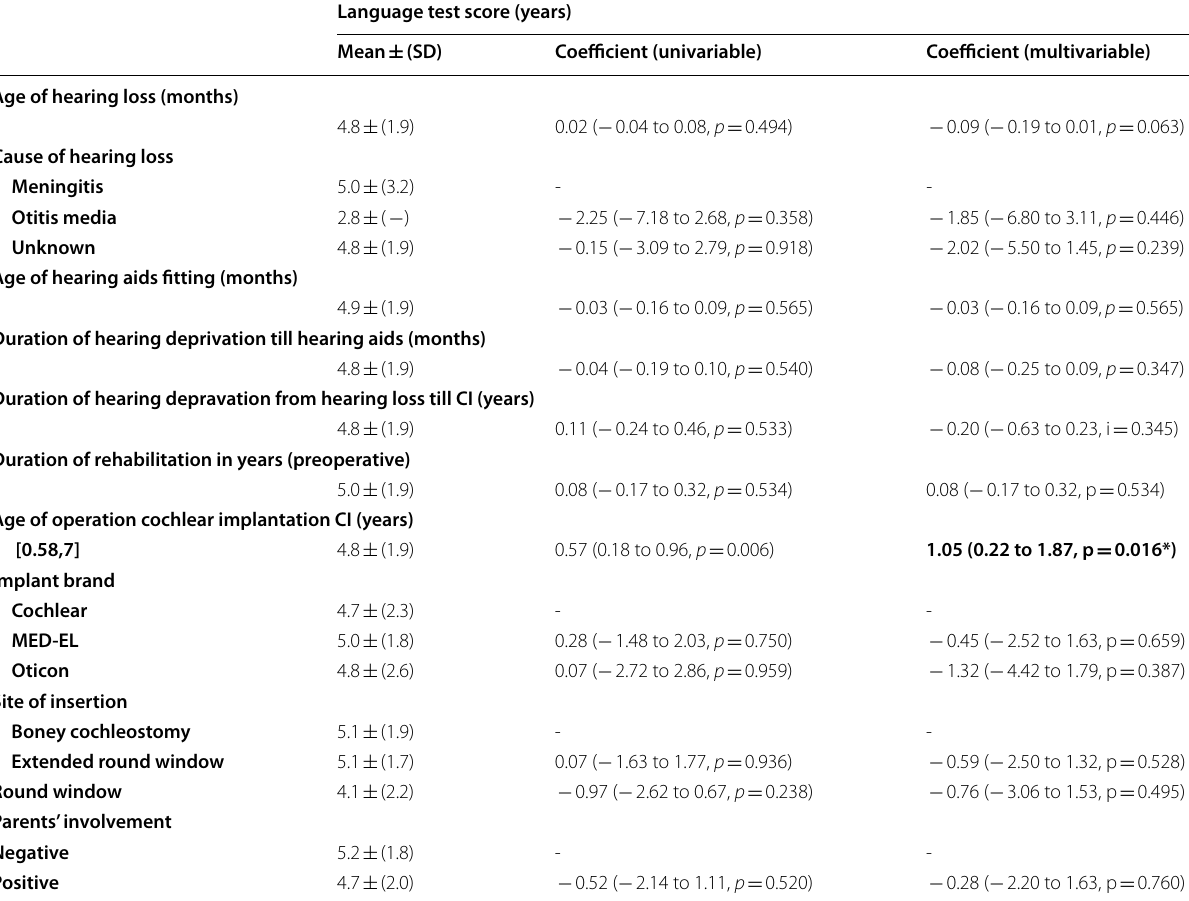
Table 5 Multivariate linear regression of language test score (years)